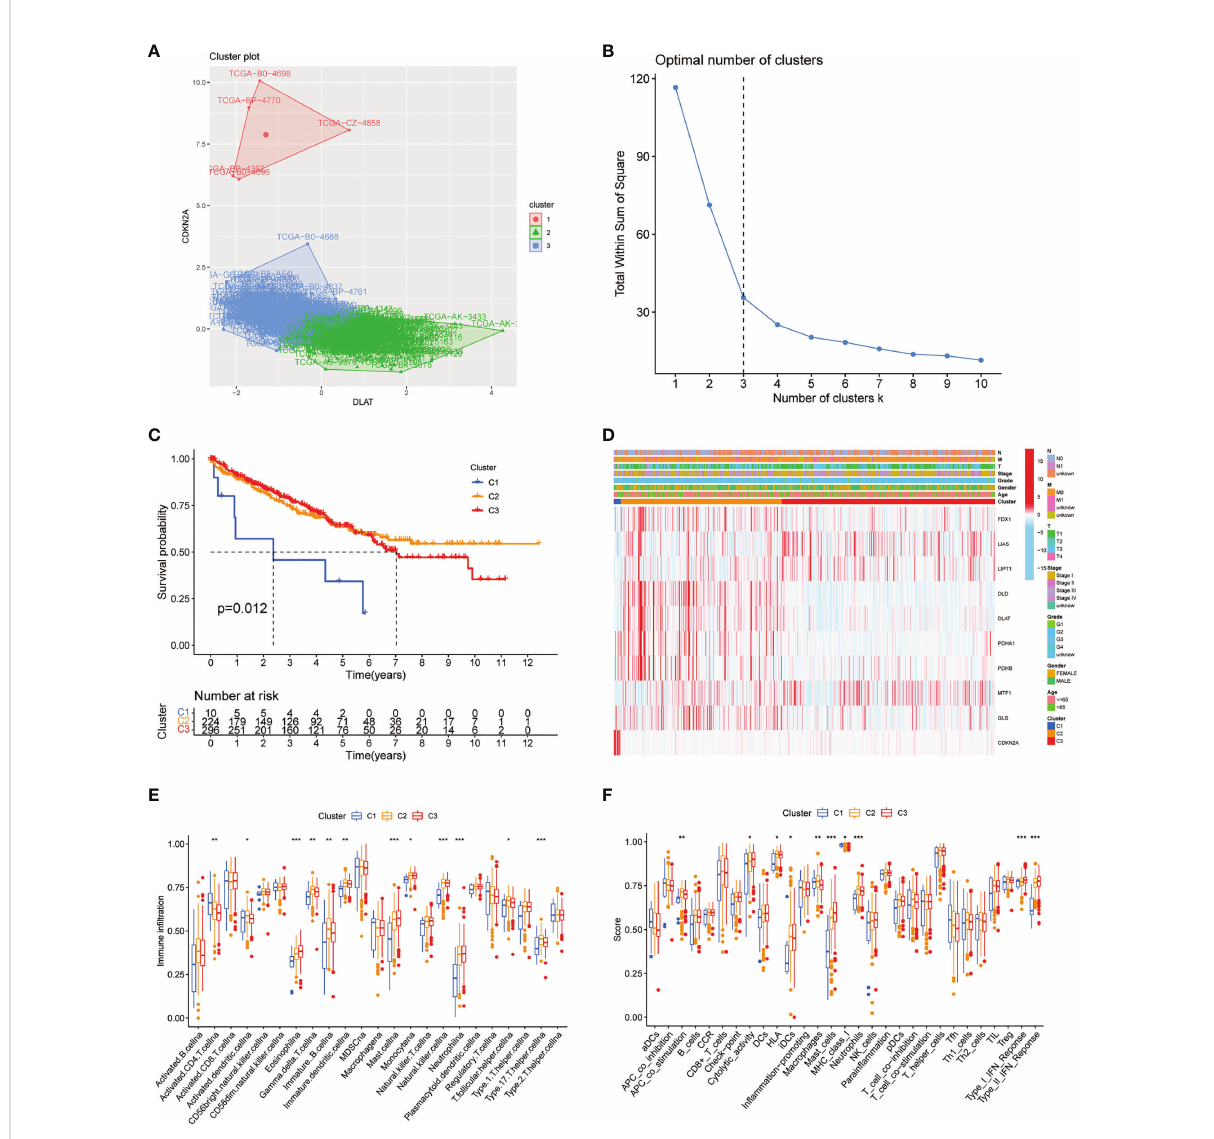
FIGURE 3 CAG pattern-based grouping of patients with distinct clinical and immune features. (A) PCA analysis indicates the separation of subgroups in the ccRCC cohort from TCGA database. (B) K-means curve suggests the optimal number of clusters. (C) Kaplan – Meier survival curves of three subgroups. (D) Heatmap of different clinicopathological features in three subgroups. Analysis of immune cell in fi ltration level (E) and immune- related function (F) between three subgroups. PCA: principal component analysis. TCGA: The Cancer Genome Atlas. KEGG: Kyoto Encyclopedia of Genes and Genomes. GSVA: gene set variation analysis ( p < 0.05 *; p < 0.01 **; p < 0.001 ***. NS, not signi fi